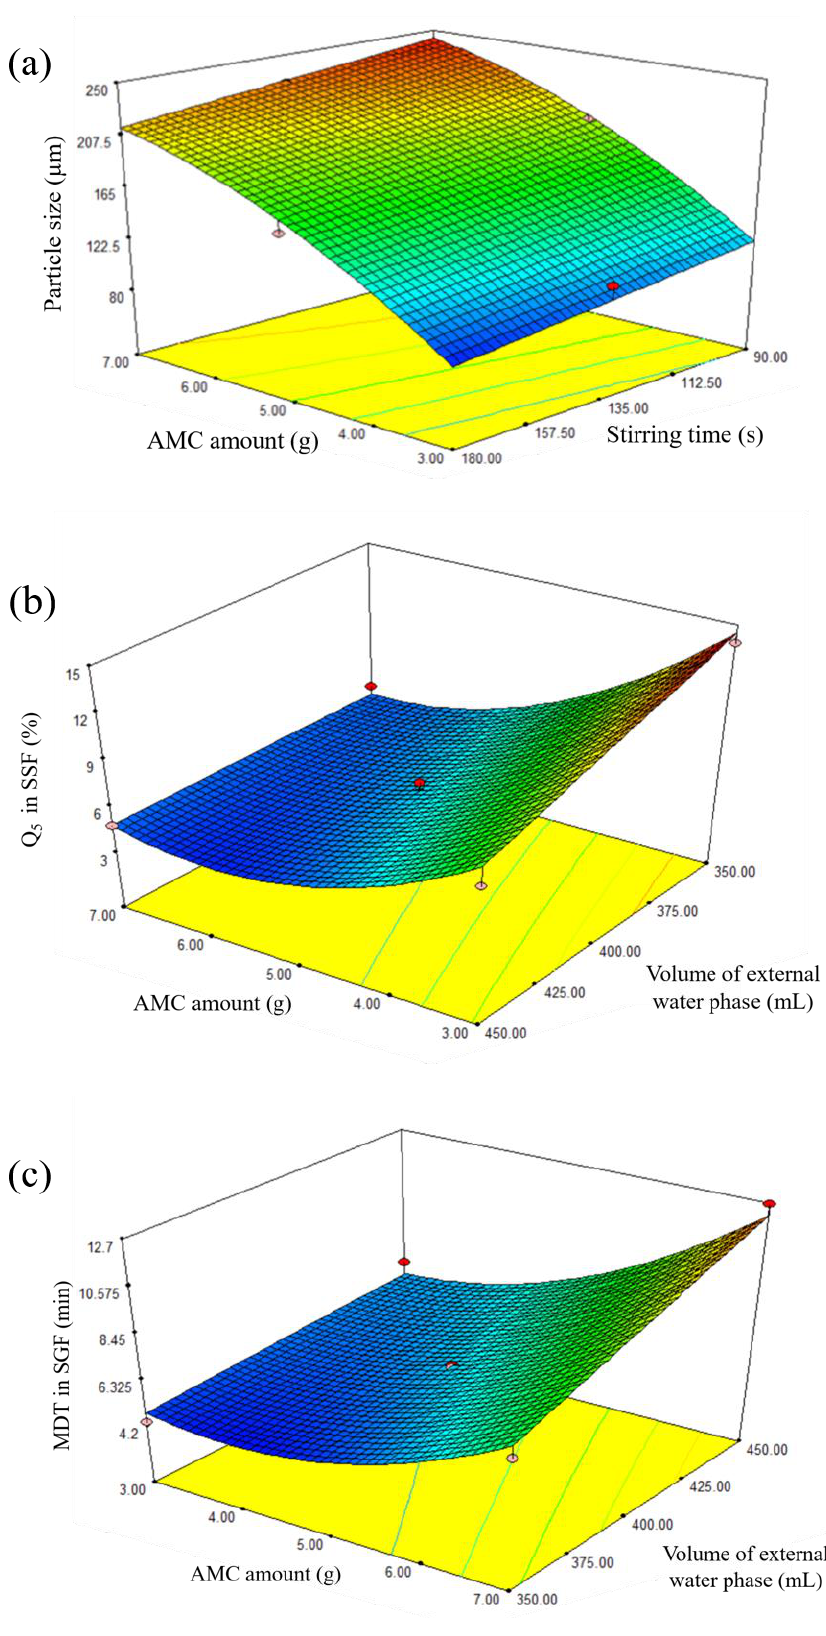
Figure 3. Three-dimensional plots showing the effect of independent factors on ( a ) size of microparticles, ( b ) Q 5 in SSF, and ( c ) MDT in SGF .